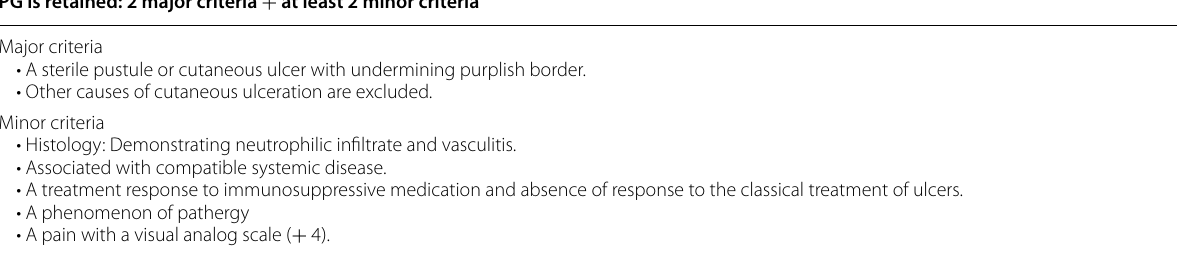
PG is retained: 2 major criteria